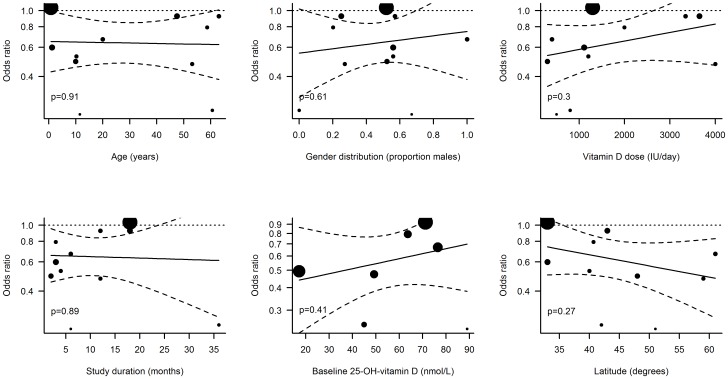
Random effects meta-regressions.Dotted lines indicate 95% confidence intervals of regression lines (solid lines). Sizes of dots are proportional to the weight of each trial in the regression model.